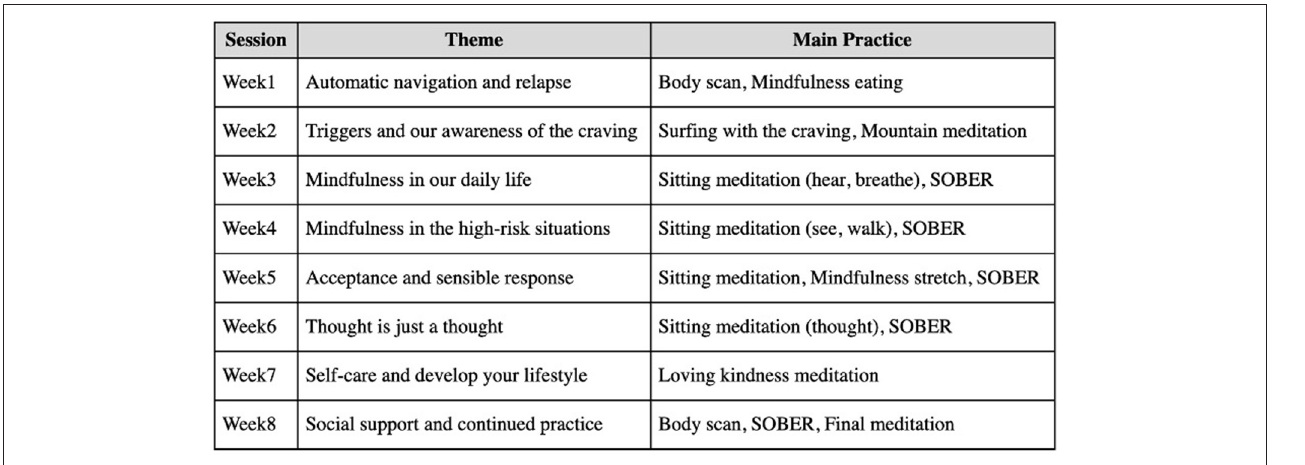
FIGURE 2 | The main content of each intervention